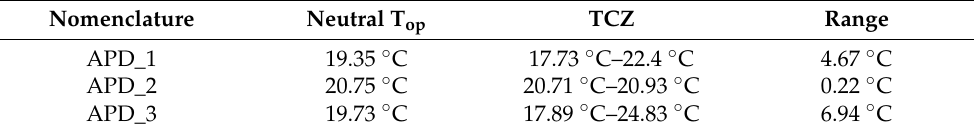
Table 10. Neutral Top and TCZs.